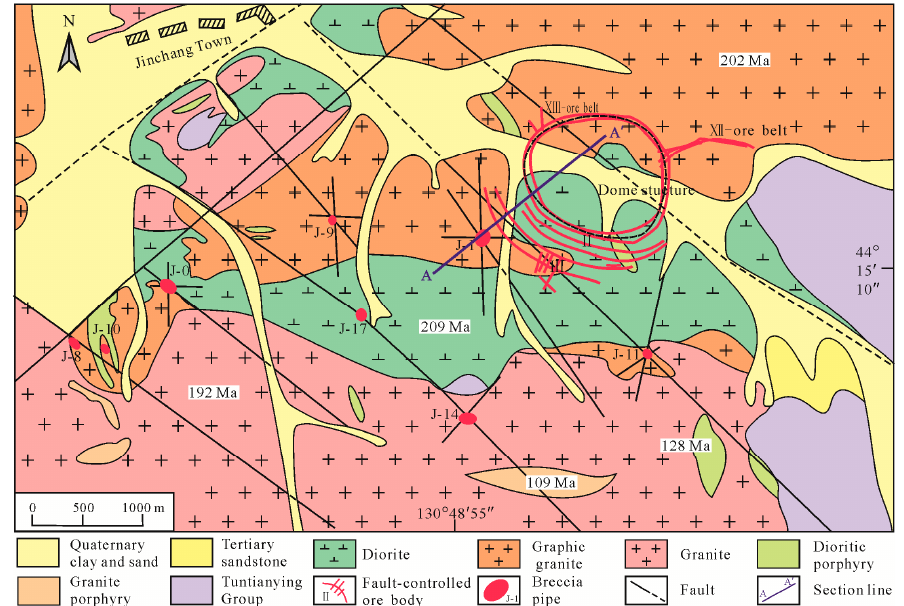
Figure 2. Geological map of the Jinchang gold–copper deposit (ages of igneous rocks are annotated on the map) [18].